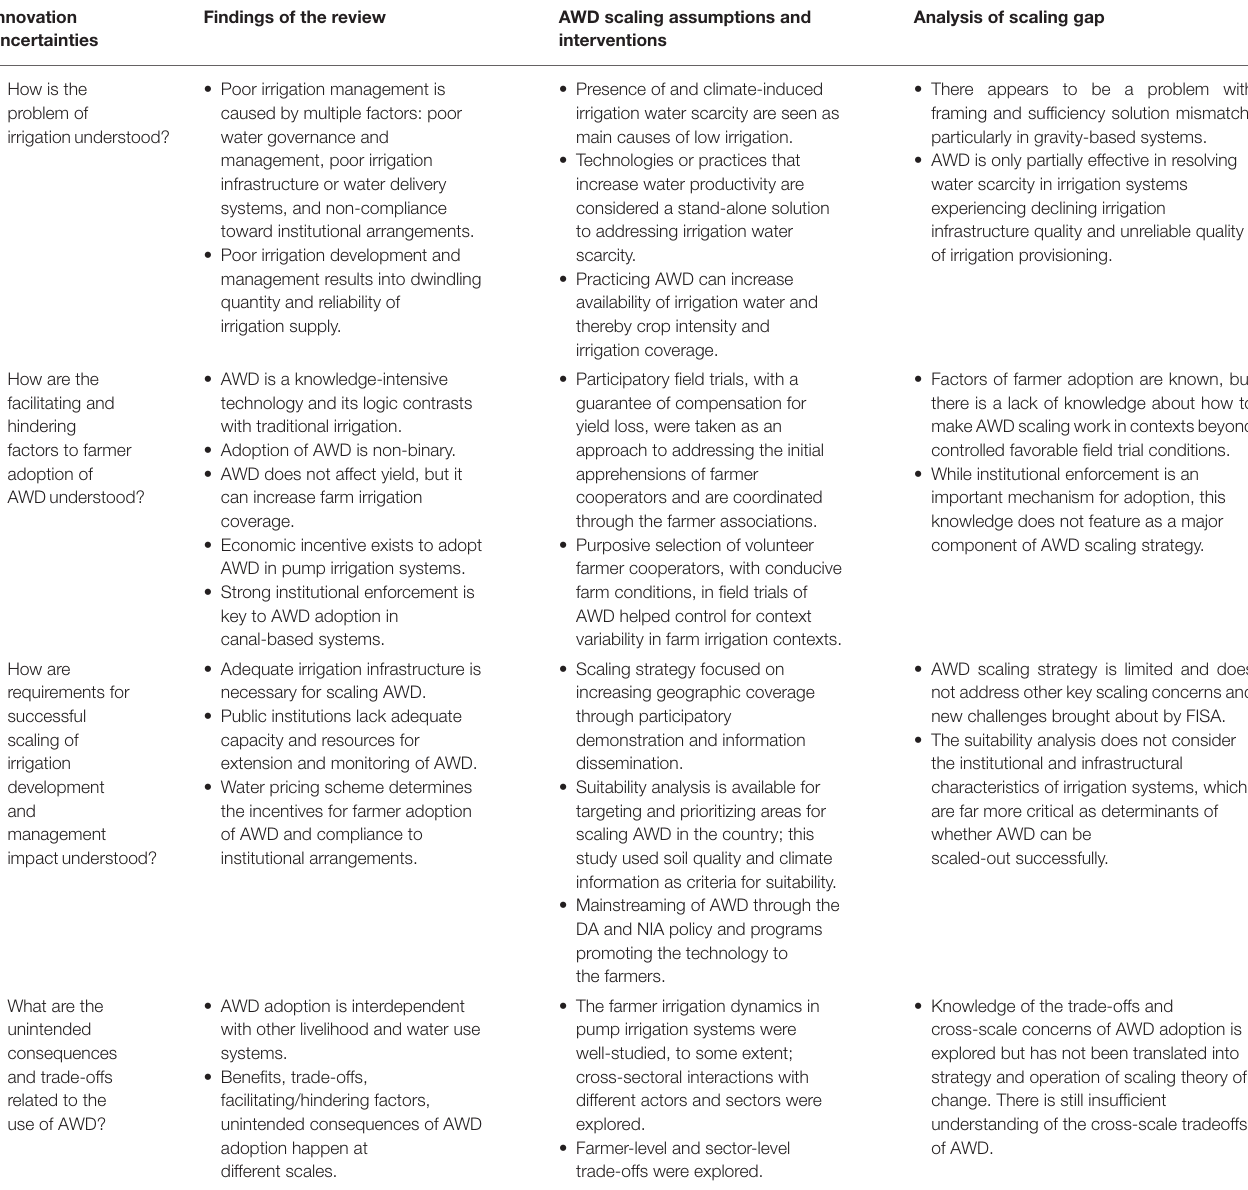
TABLE 2 | Overview of AWD scaling strategies (thus far) and